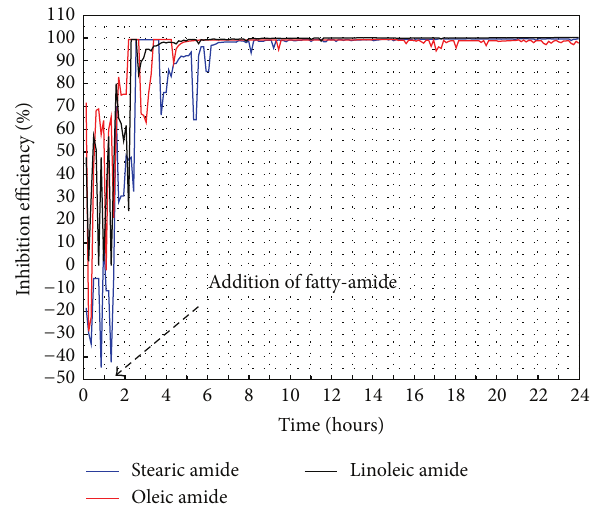
Figure 15: Variations of inhibition efficiency as determined by LPR measurements ( monitoring real-time ).